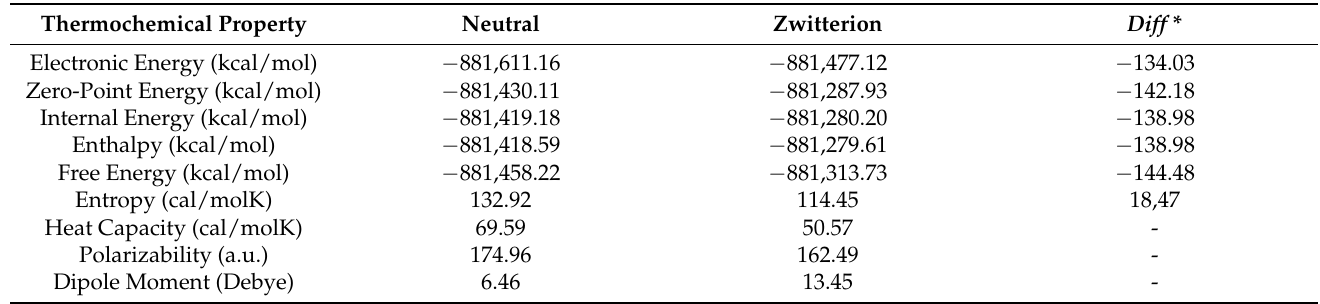
Table 2. Glutathione thermochemical properties obtained at the M06-2X/6-311++G(d,p) level Figure 3. Comparison graphs of the geometric parameters’ bond length and angle, obtained by XRD of theory. and the M06-2X/6-311++G(d,p) level of theory for the glutathione.